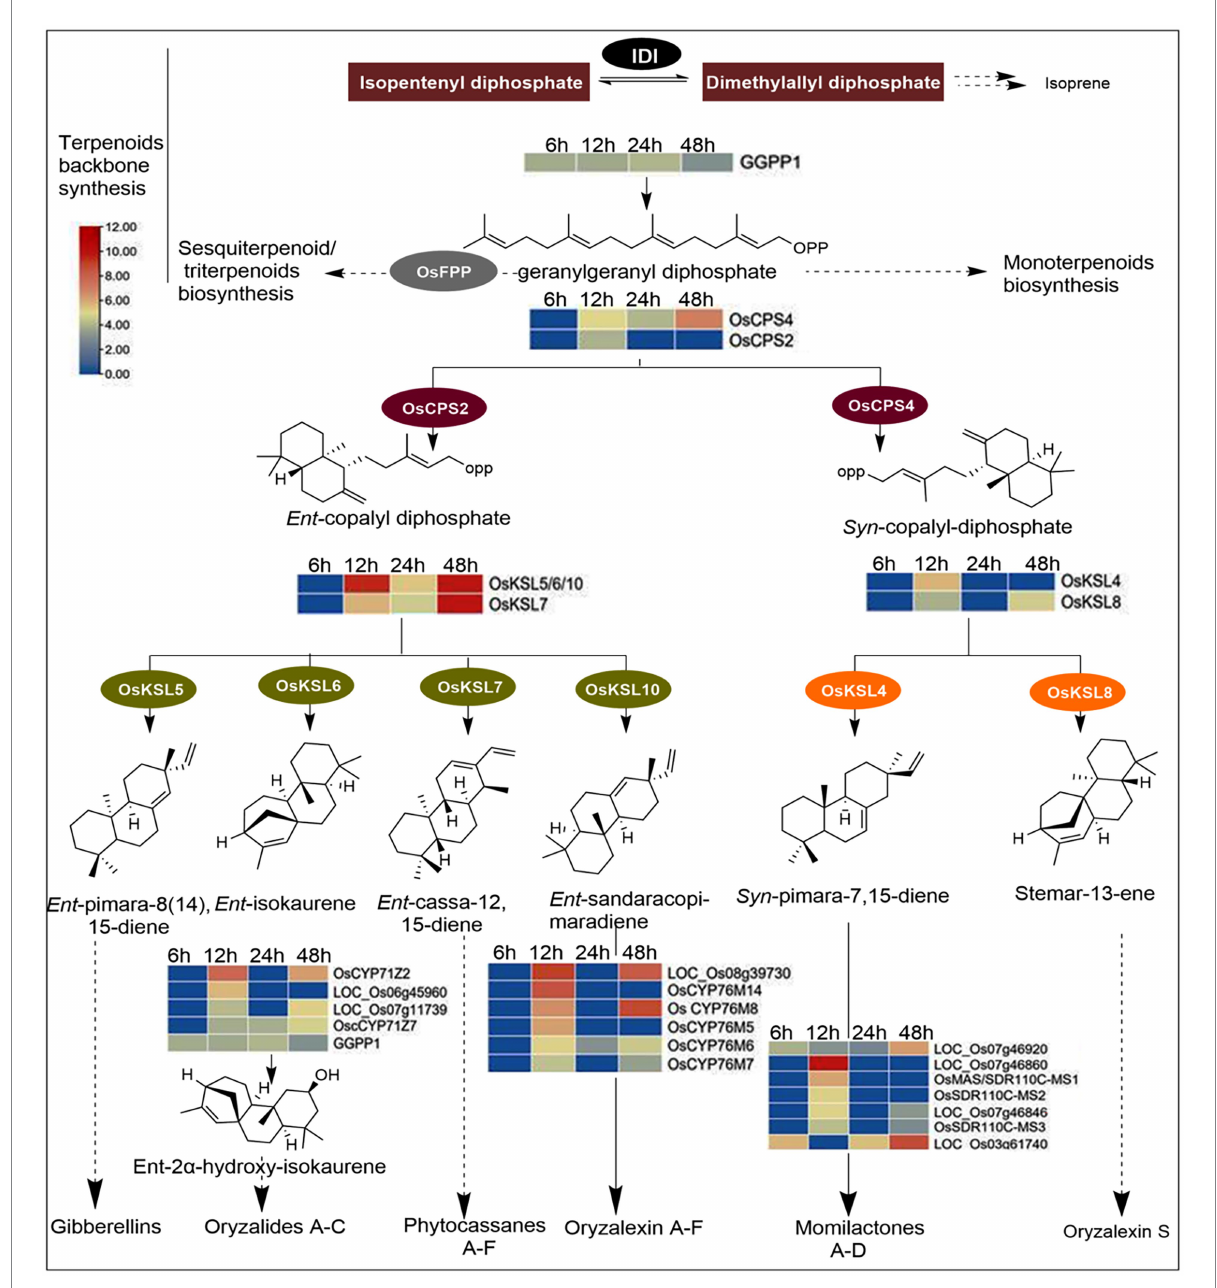
FIGURE 4 Diterpenoids biosynthesis pathway illustrating the functions of Hrip1-activated genes. Heat maps were constructed from log2fold values of DEGs. Genes encoding steps with dash arrows were non-responsive to Hrip1 treatment. Diphosphate isomerase